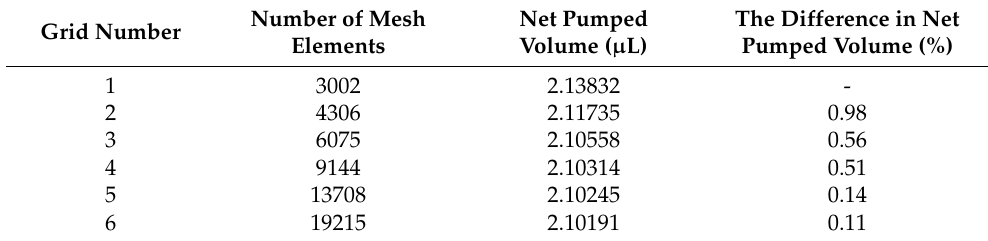
Figure 6. Net volume pumped is calculated for different numbers of elements.